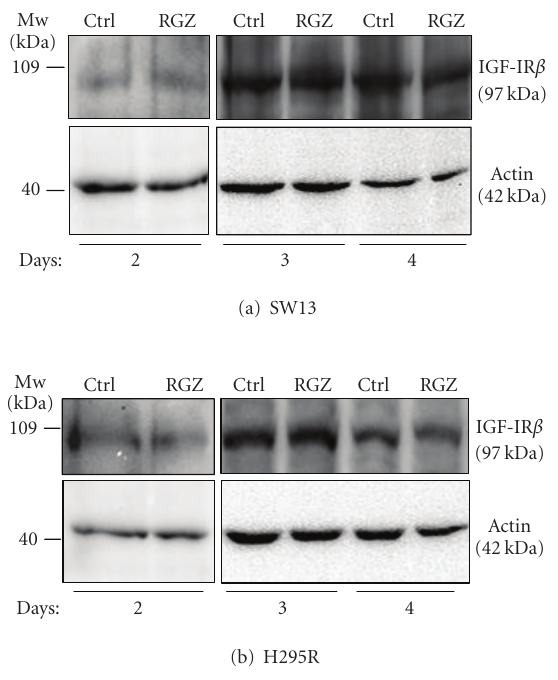
Figure 8: RGZ does not a ff ect IGF-IR levels . Western blot analysis of SW13 (a) and H295R (b) cell lysates following 2, 3, and 4 day cell incubation in the absence (Ctrl) or in the presence of 20 μ M RGZ reveals no significant change in IGF-IR (upper panels). Lane protein normalization for actin is shown in the lower panels. Molecular weight markers are indicated. Representative of two independent